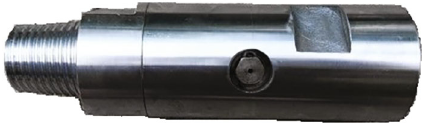
Figure 9: Schematic diagram of high and low voltage conversion